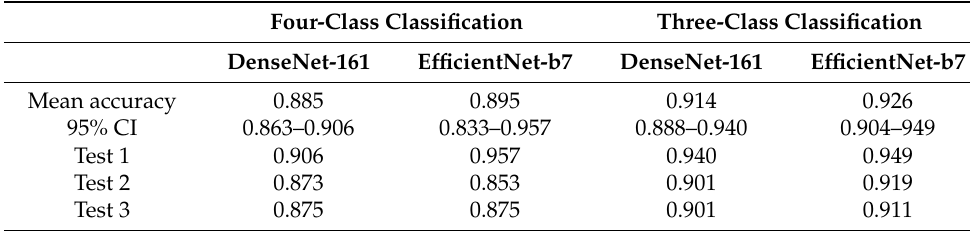
Table A1. Accuracies of deep learning models.